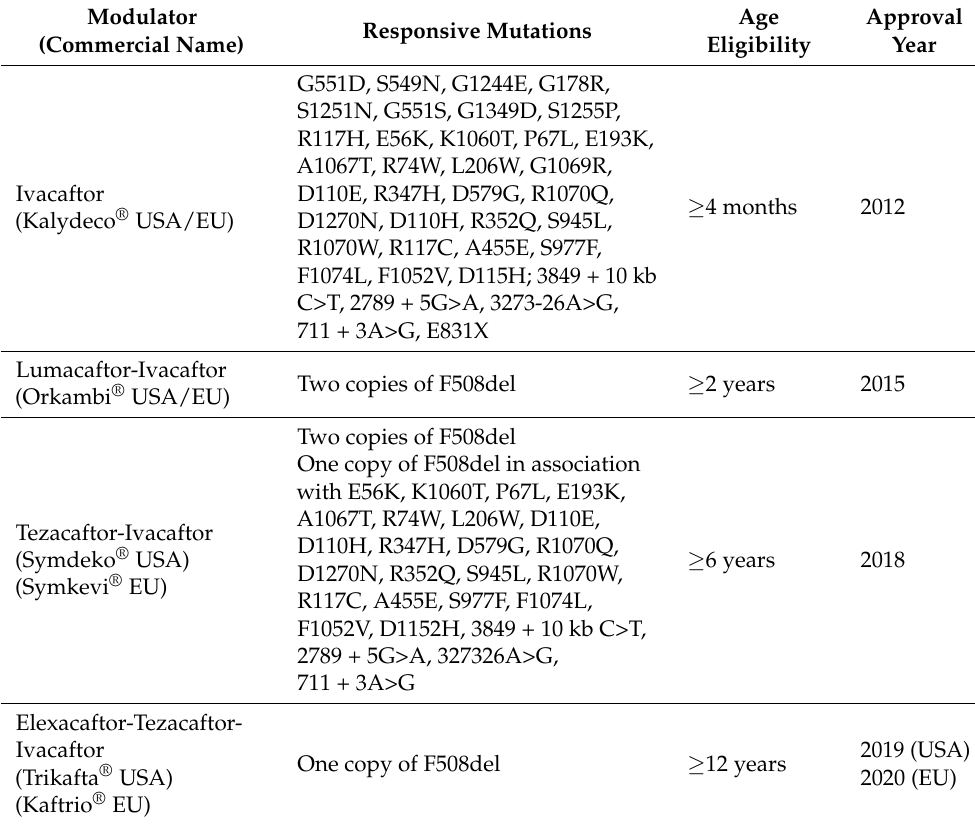
Table 1. Approved CFTR